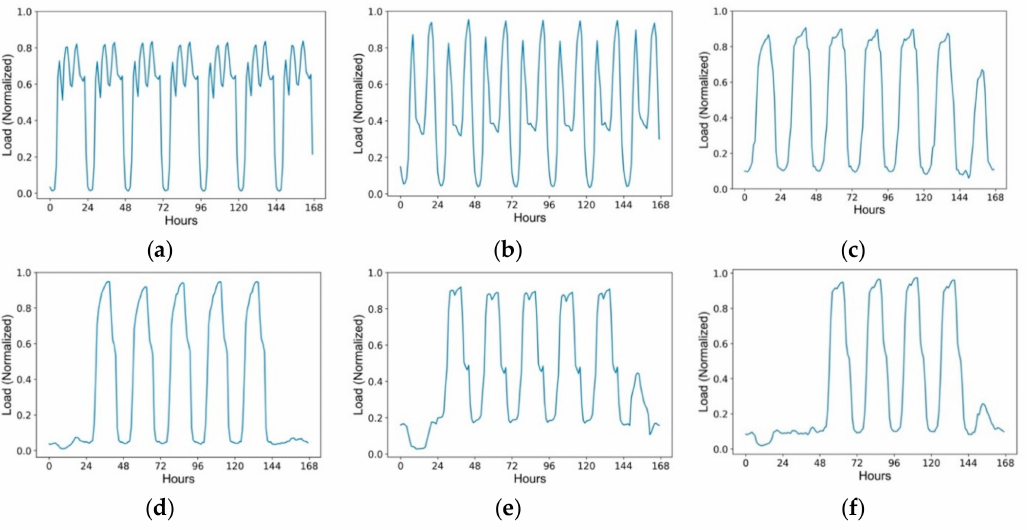
Figure 9. Six typical local patterns in short-term: ( a ) daytime highest; ( b ) morning and evening; ( c ) lunch time highest; ( d ) normal working day 1; ( e ) normal working day 2; ( f ) normal working day